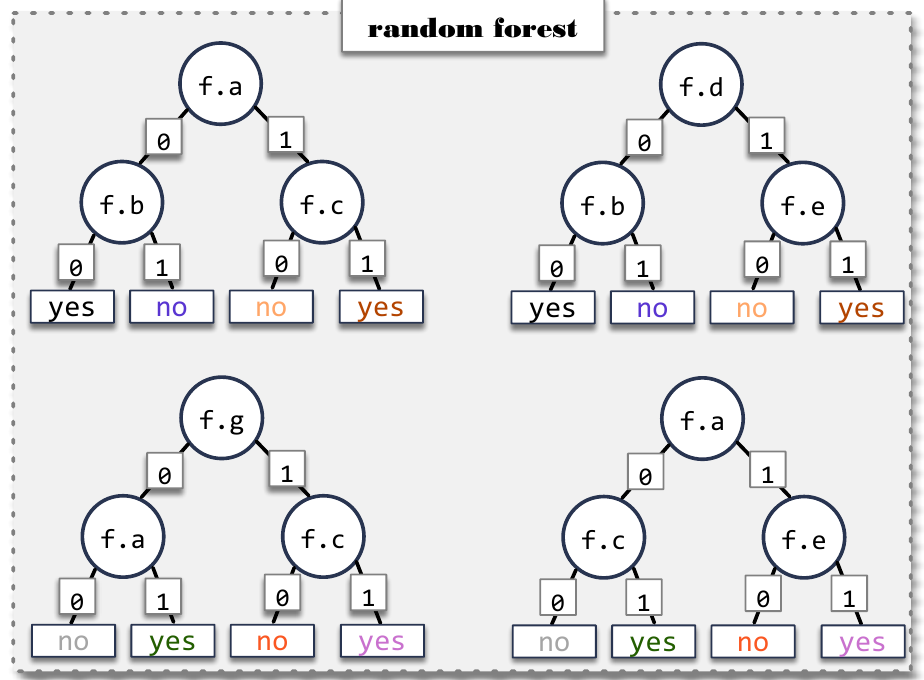
Figure 4. Example of a random